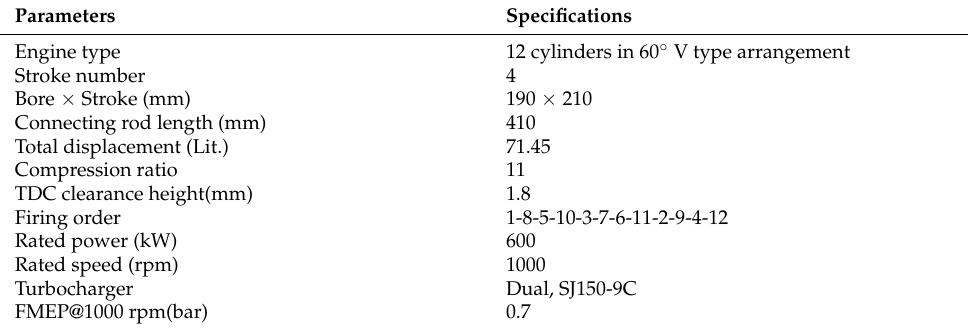
Table 1. Technical specifications of 12V190 NG